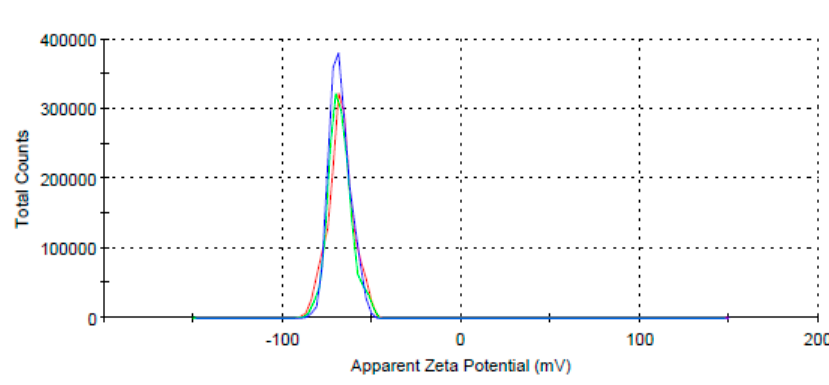
Figure 2. Zeta potential of SMCs [22] (three times repeated).